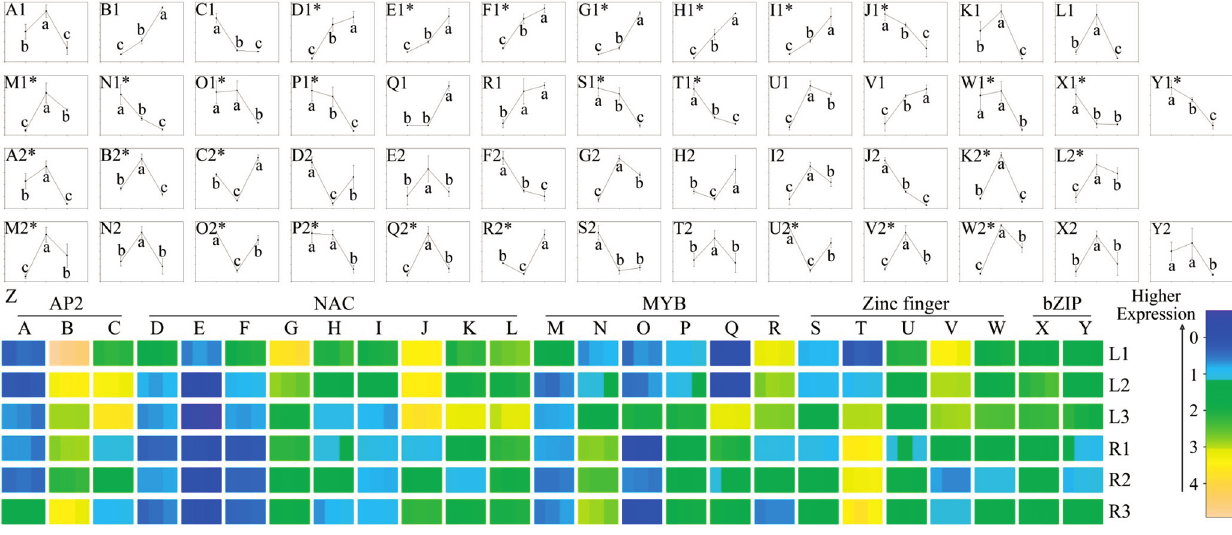
Figure 6. Expression analysis of 25 transcription factors. Specifically,